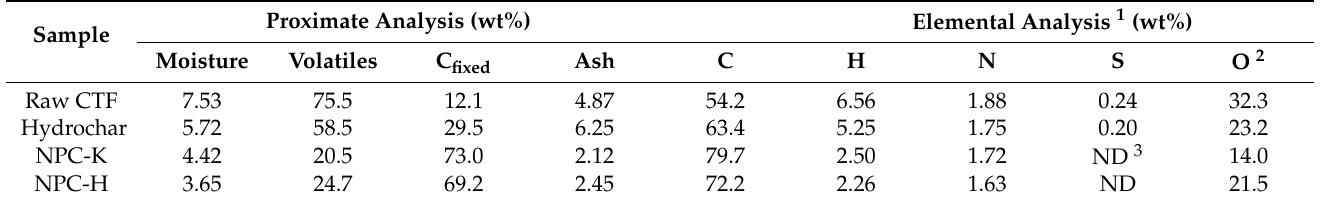
Table 1. Proximate and elemental analyses of the CTF precursor, NPC-K, and